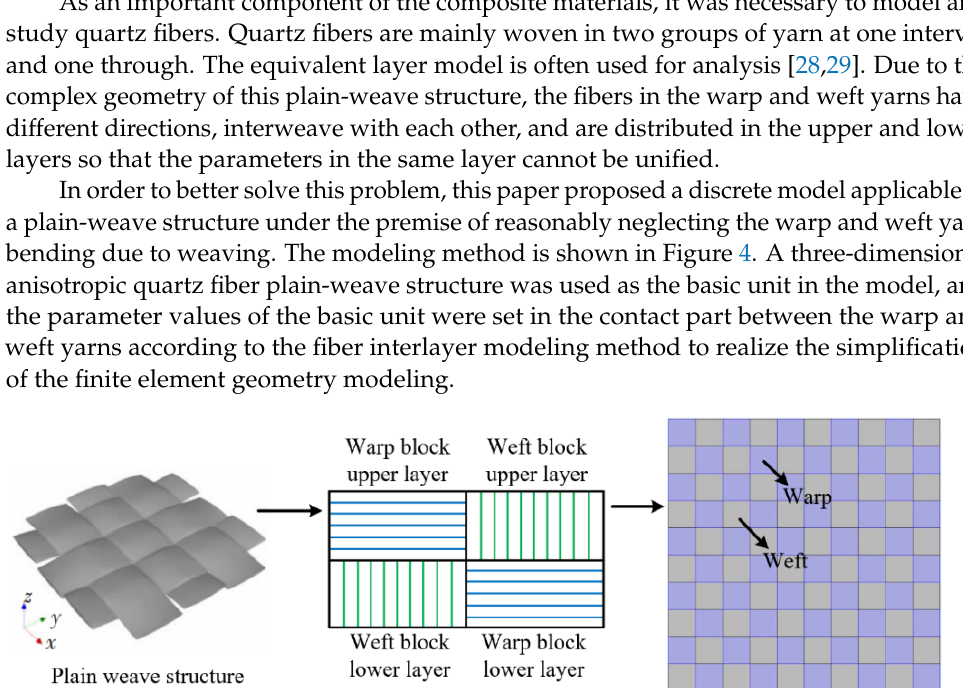
Figure 4. Quartz fiber discretization simulation model.